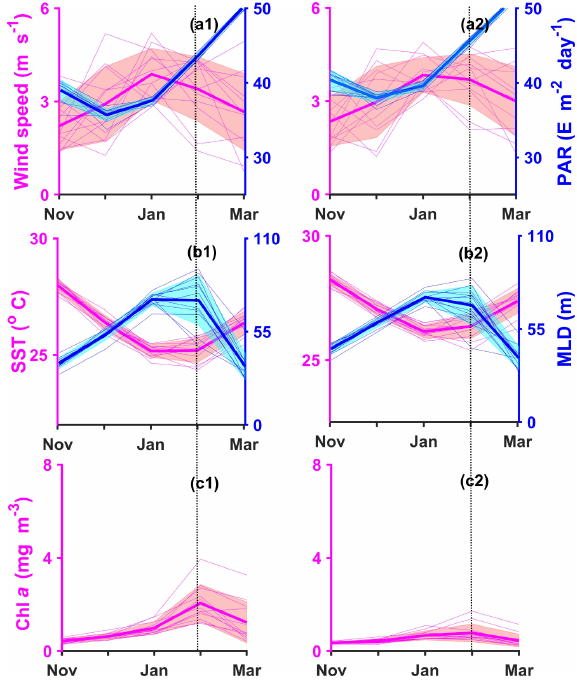
Figure 6. Temporal variability of wind speed and PAR (a) , SST and MLD (b) and surface Chl a (c) averaged for zone 3 (left, denoted by suffix 1) and zone 4 (right, denoted by suffix 2) during the win- ter period for the years 2002–2013. Pink colour is used to represent Chl a , SST and wind speed and blue represents MLD and PAR. Thick lines represent means and the shaded areas the standard de- viation for each parameter. The time series for the individual years are shown using thin lines. Vertical dotted lines represent the timing (month) of peak algae blooms in each